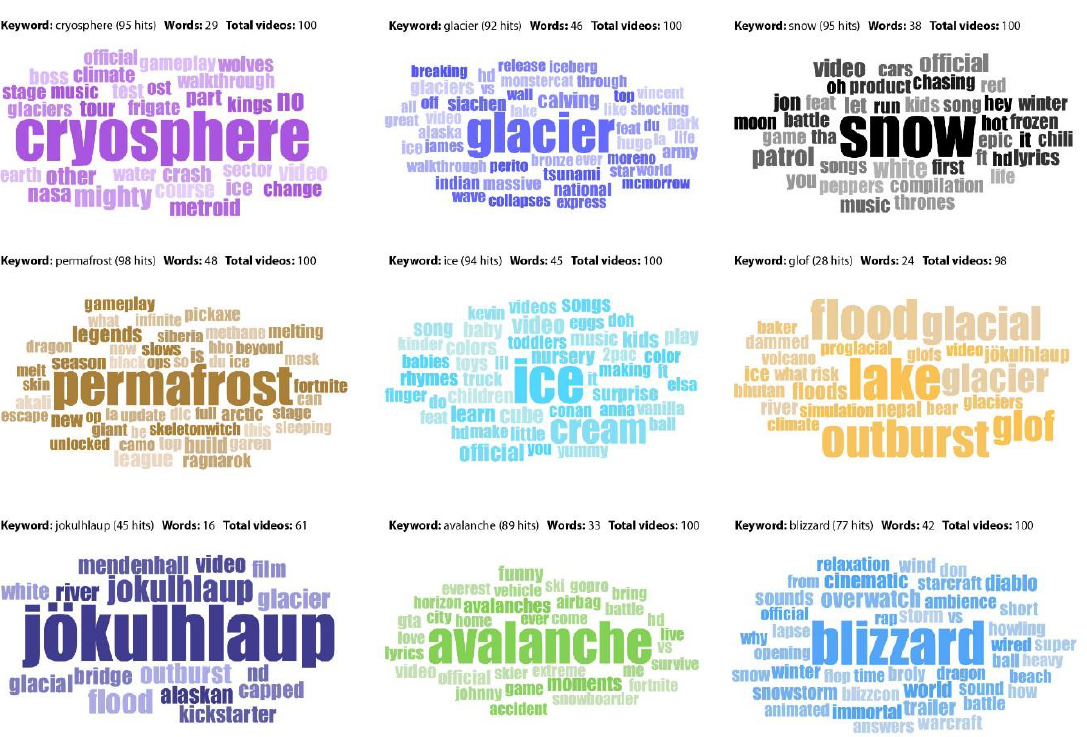
Figure 2. The most frequently used words in the titles of videos including individual cryospheric keywords. Frequency of the word occurrence is expressed by font size—the higher frequency the bigger font (in the figure shown as a number of hits for the selected keywords, e.g., 98 hits for permafrost or 28 hits for GLOF), and is not comparable between di ff erent word clouds. Di ff erent color tones are only used to increase readability, they do not refer to any variable. Only words appearing three or more times are shown in these word clouds.